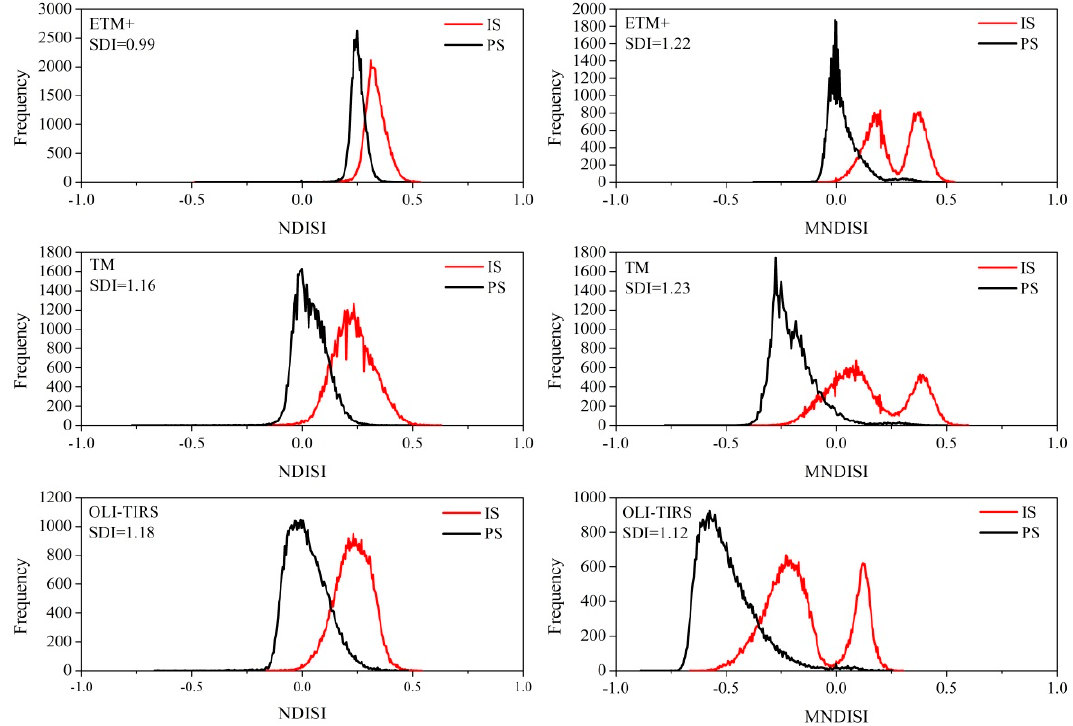
Figure 10. The IS and PS histograms and SDI values of the NDISI ( left column ) and MNDISI ( right column ) from summer images of: ETM+ acquired on 29 August 2001 ( the first row ); TM acquired on 30 August 2010 ( the second row ); and OLI/TIRS acquired on 13 July 2016 ( the third row ).